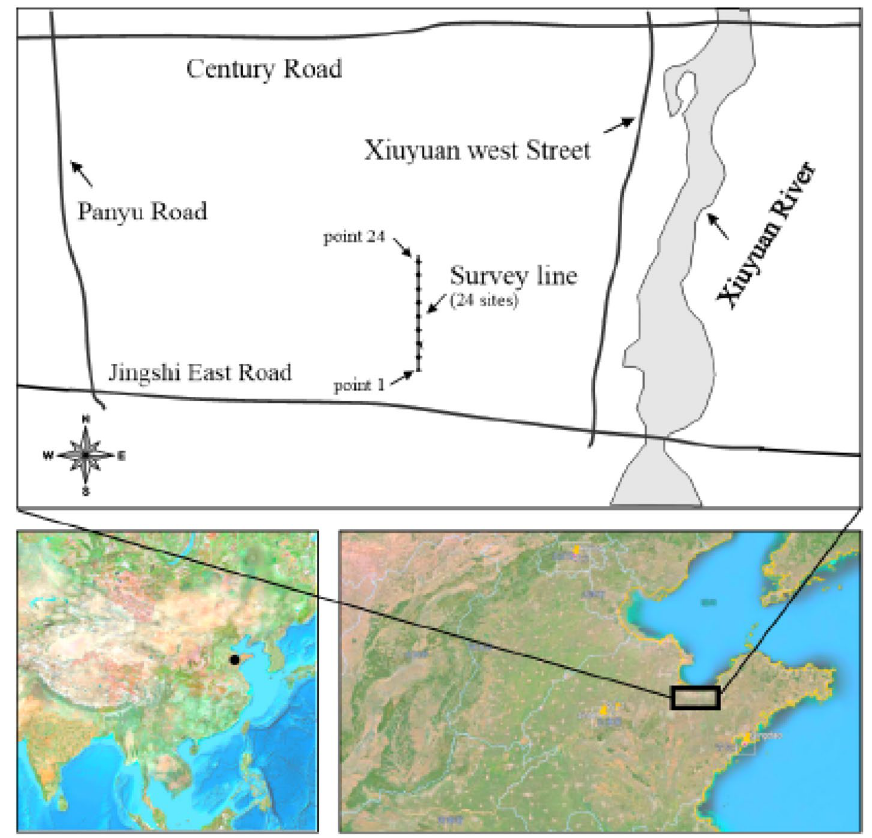
Fig. 7 Location of the field site east of the city of Jinan, Shandong Province, China, illustrating the acquisition of surface-based TEM